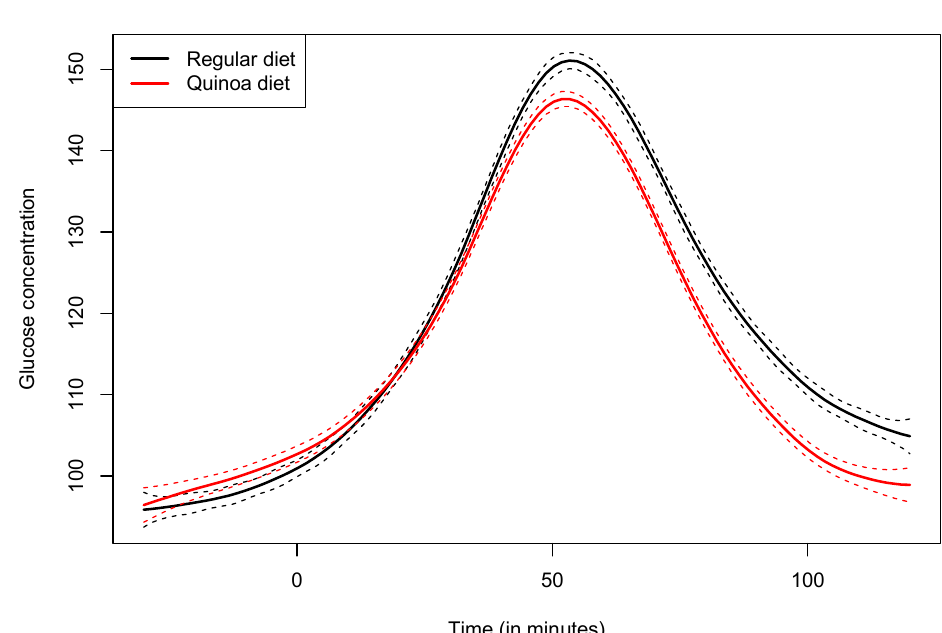
Figure 2. Coefficient estimate of functional regression model with diet factor.